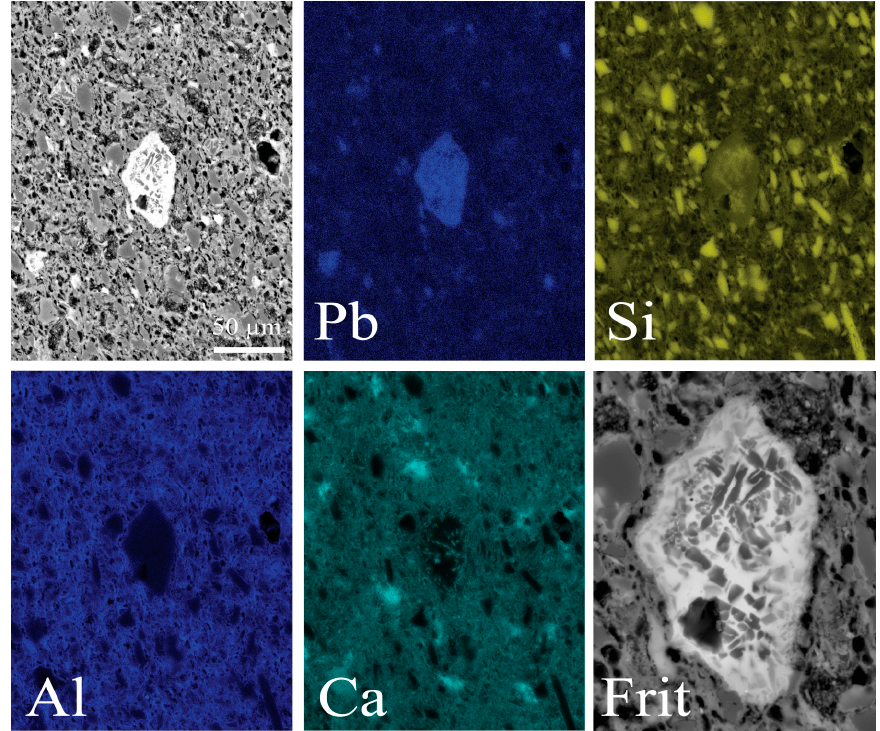
Figure 9. SEM-BSE image of a CaO-rich watch stand (Figure 6d) from Saint-Clément, [16] (An. No. TBL 21), showing tiny angular fragments of crushed quartz and angular to subrounded fragments of coarser PbO-SiO 2 -frits, as well as the corresponding elemental maps of Pb, Si, Al, and Ca. The close up of the frit reveals neoformations (grey to black needles and grains) of presumed cristobalite and wollastonite crystals in a glassy Pb-rich matrix (white).